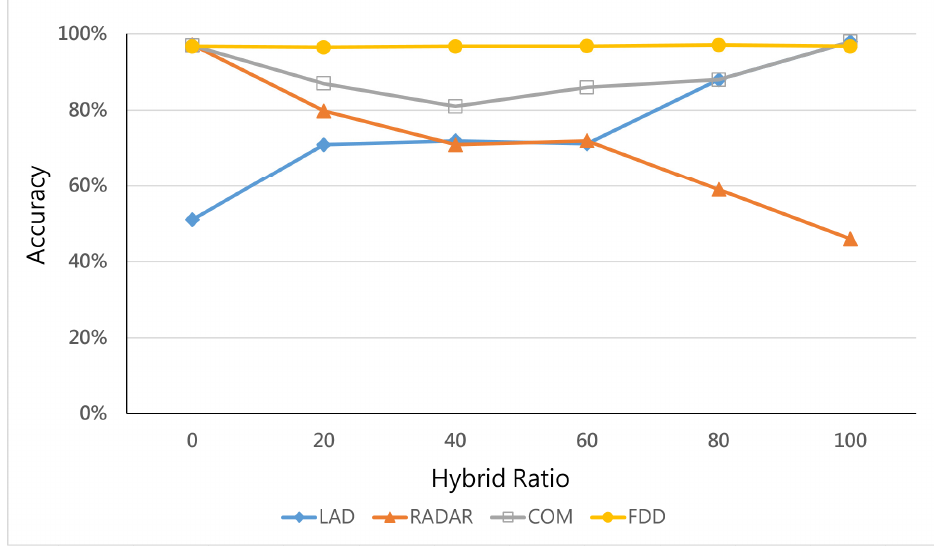
Figure 6. FNR and FPR vs. hybrid ratio. 6.5. Effects of the Number of Servers in Target Area This experiment attempts to explore the performance of all methods detecting the hybrid attack and the synergy effect of different numbers of servers in the target area. The environment setting is that the hybrid ratio is equal to 0.4 in the topology with seven switches. Figure 7 shows that, when there is only one server in a target area, all methods have good detection accuracy above 90% because all these methods merely watch over the traf- fic related to this server. However, as the number of servers in the target area increases, the traditional detection methods, i.e., LAD, RADAR, and COM, experience low detection accuracy. On the other hand, our proposed FDD still has a stable detection accuracy per- formance. Figure 8 also supports the above argument that traditional studies experience